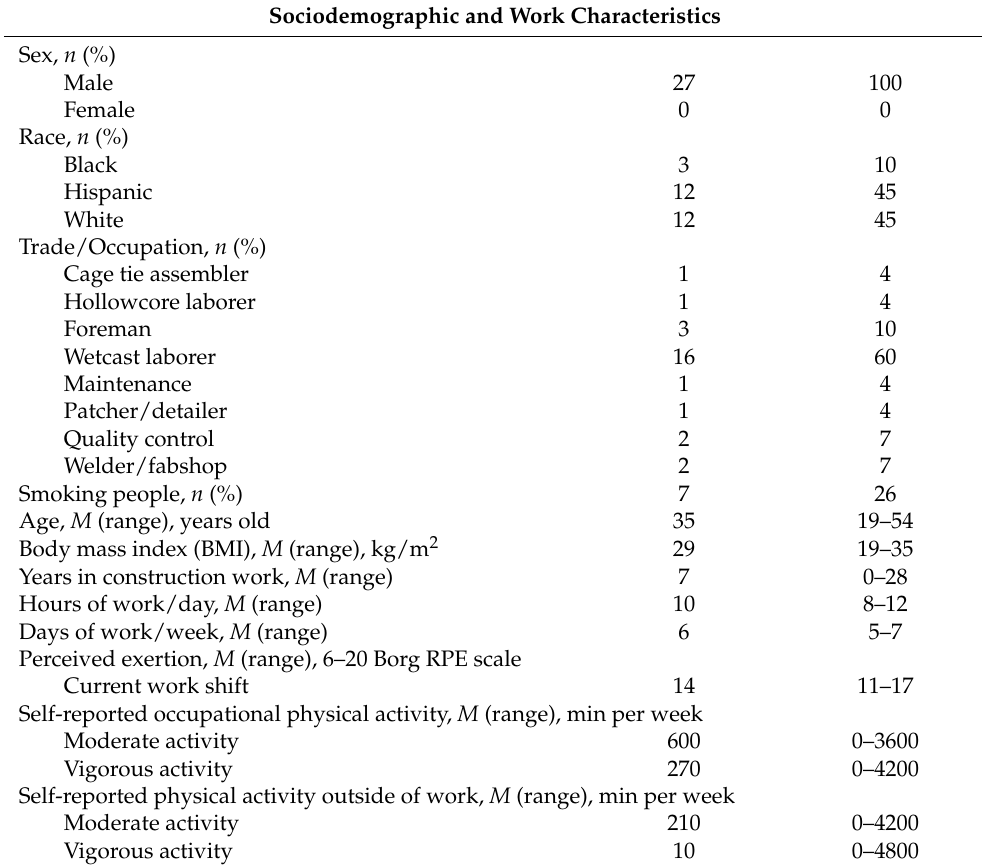
Table 1. Sociodemographic and work characteristics among the participants ( n = 27). Sociodemographic and Work